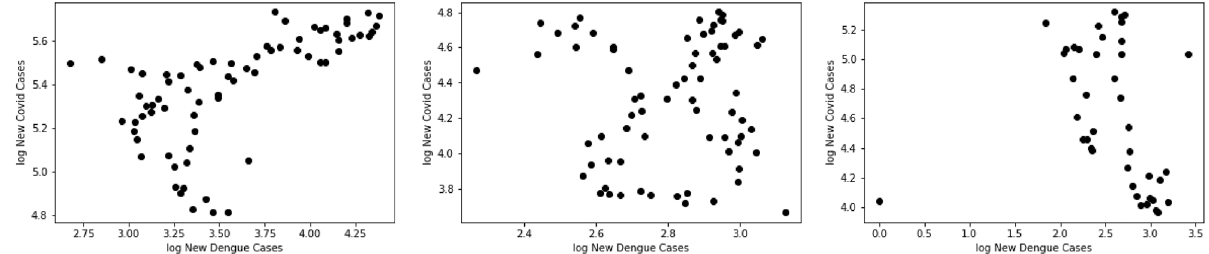
Figure 3. Dengue and COVID-19 cases plotted for Brazil (left), Peru (middle), Colombia (right). The data is normalized via taking the base 10 logarithm, and the graph is representative of what happens with the entire population.